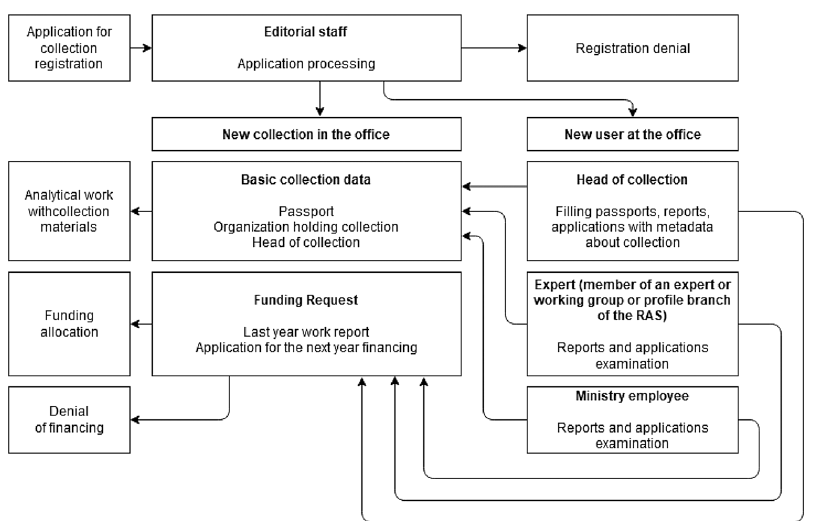
Figure 3: The workflow of the project office users